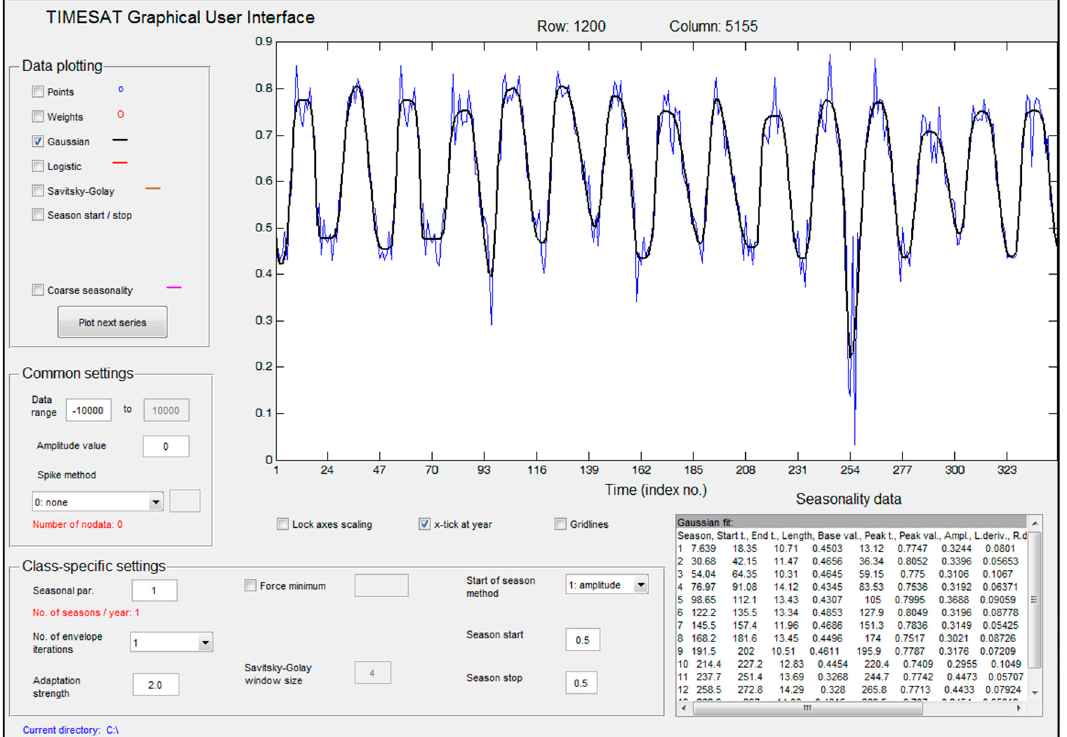
Figure 3. TIMESAT Graphic User Interface window showing the graph for one pixel’s NDVI over 14 years.